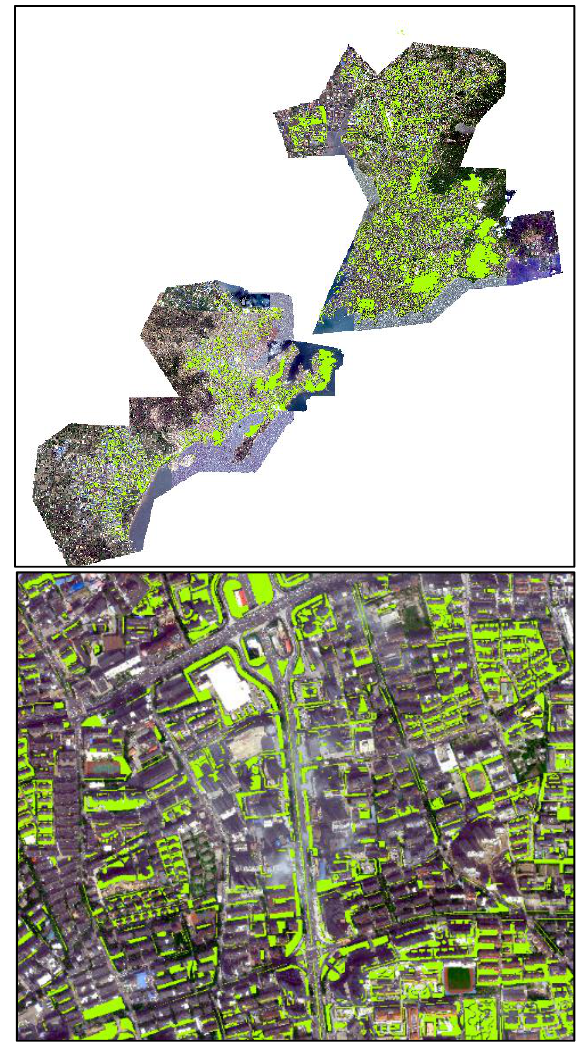
Figure 8. Greenery extraction result in built-up areas of city X The whole process including training sample preparation and automatic extraction cost 10 days while it would cost 170 days to manually interpret the greenery